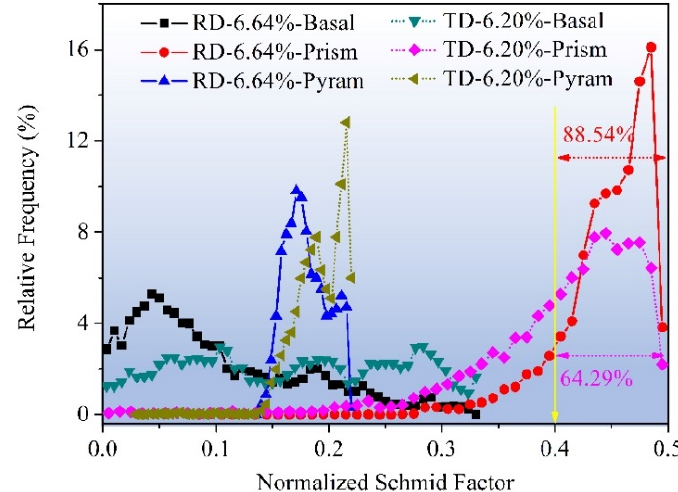
Figure 11. Cumulative distributions of SF N of grains calculated from the EBSD data of the RD and TD deformed samples.